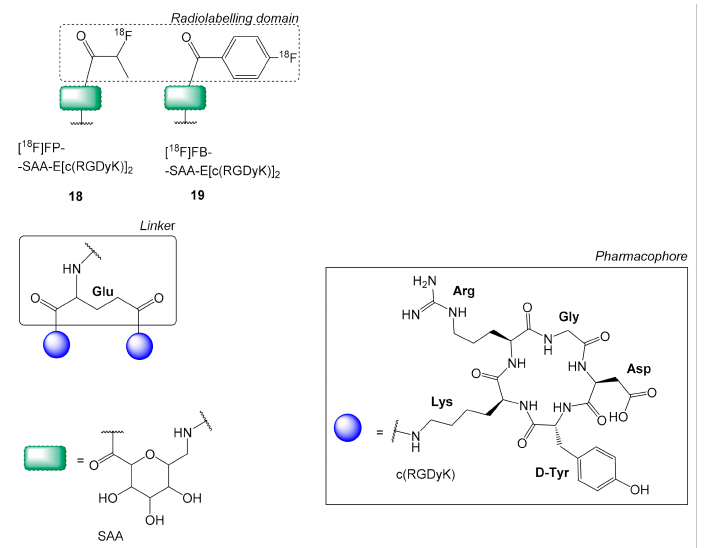
Figure 6. Chemical structures of [ 18 F]FP-SAA-E[c(RGDyK) 2 18 , [ 18 F]FB-SAA-E[c(RGDyK) 2 19 , where SAA = 7-amino- L -glyero- L